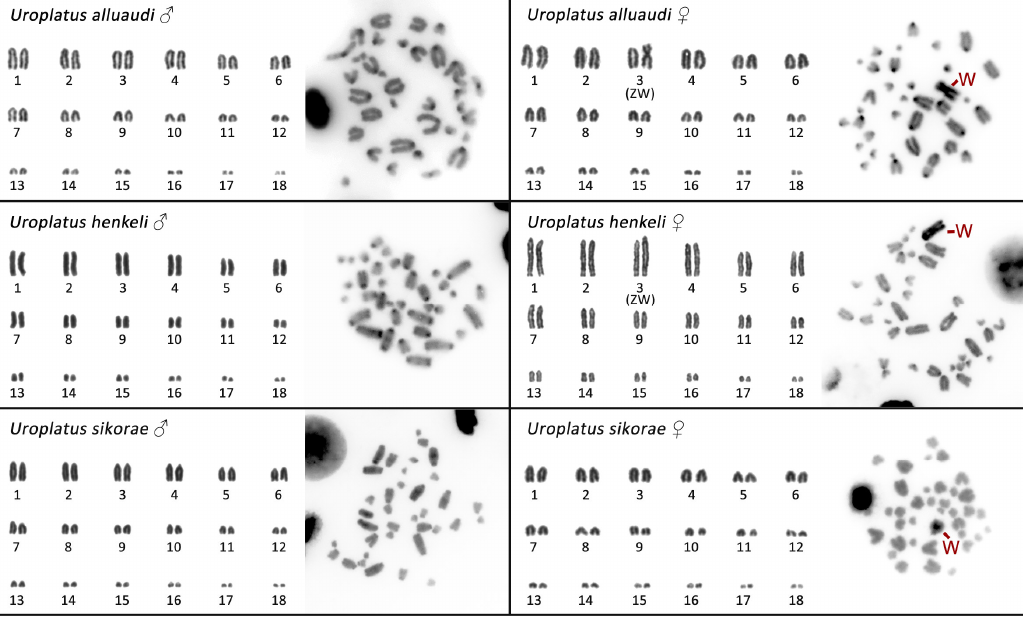
Figure 1. Karyograms and C-banded metaphases from both sexes of the Madagascar leaf-tail geckos ( U. alluaudi, U. henkeli and U. sikorae) . Sex chromosomes are indicated when we were able to identify